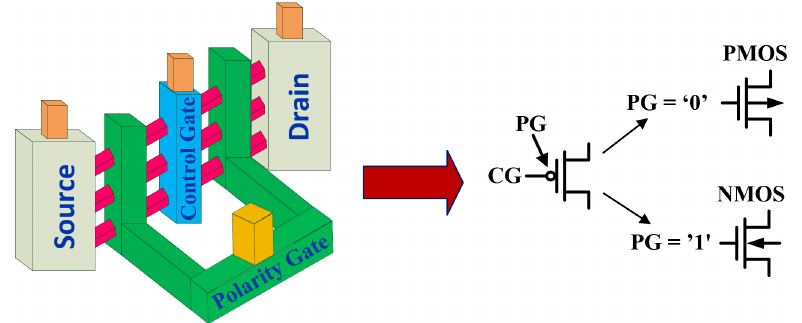
Figure 1. Three-dimensional scheme of the silicon nanowire field effect transistors (SiNW FETs) with the characteristics of two separate gates, namely, the control gate (CG) and polarity gate (PG) to form either a p-channel metal-oxide-semiconductor (PMOS) or a n-channel metal-oxide-semiconductor (NMOS) field effect transistor.